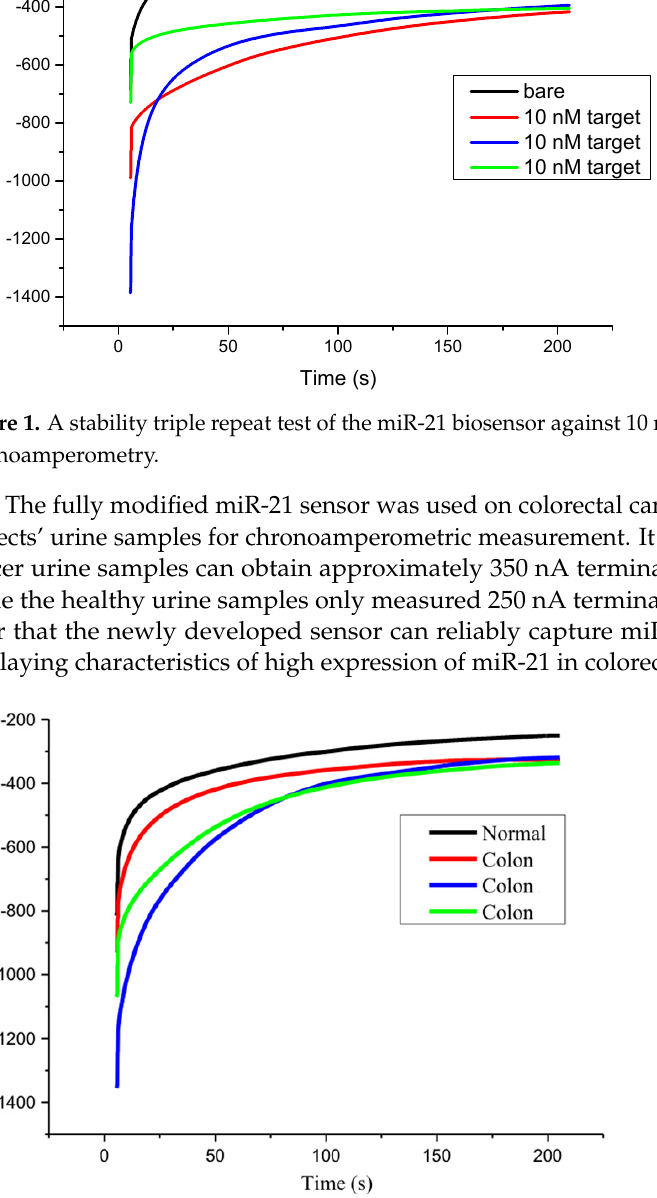
Figure 2. Stability triple testing of the miR-21 biosensor using a single colorectal cancer patient and normal urine sample, recorded with chronoamperometry.